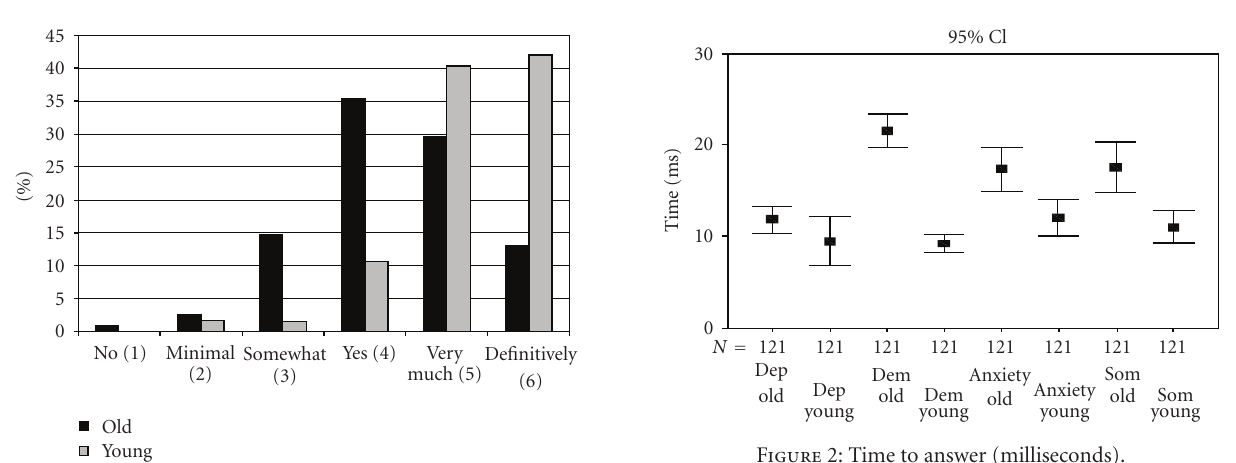
Figure 2: Time to answer